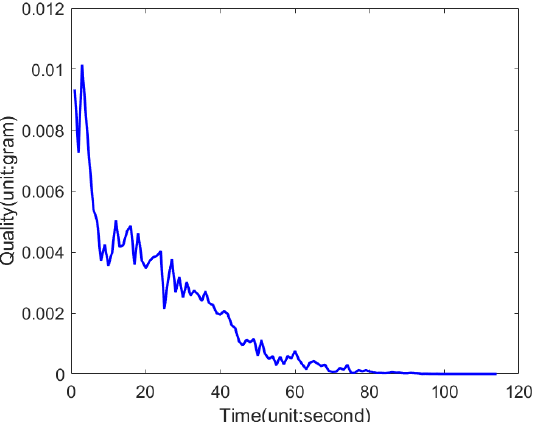
Figure 14. Graph of the mass change of silicon dioxide at each moment during the melting process in the high-temperature cell.